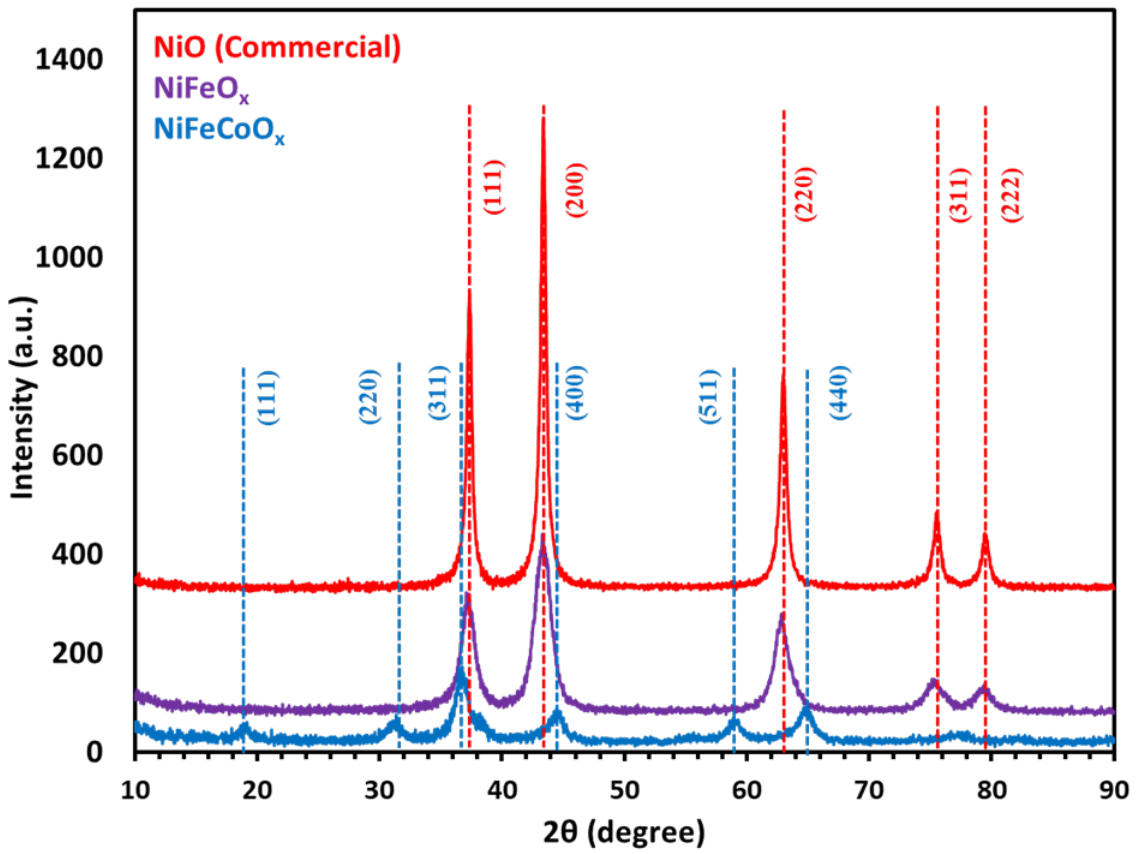
Figure 5. XRD of NiFeO x , NiFeCoO x catalyst calcined at 300 °C, commercial NiO is for reference. 4. Water Electrolysis over NiO, NiFeO x and NiFeCoO